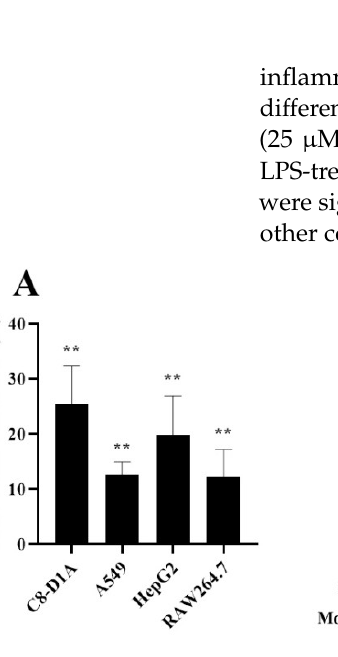
the normal cell group).